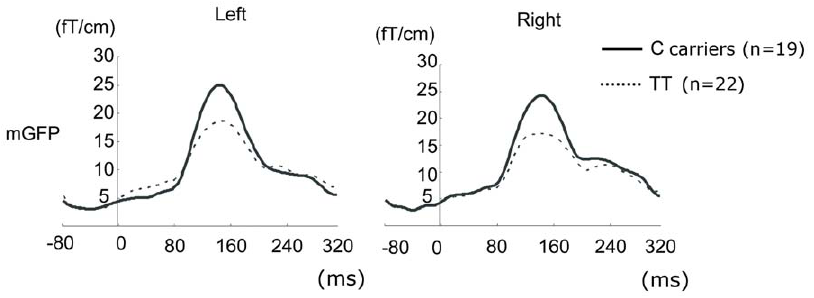
Figure 1. Grand mean mGFP waveforms of MMF. These waveforms were averaged for each GRM3 rs274622 genotype group for each hemisphere (C carriers [N=19], solid line; TT individuals [N=22], dashed